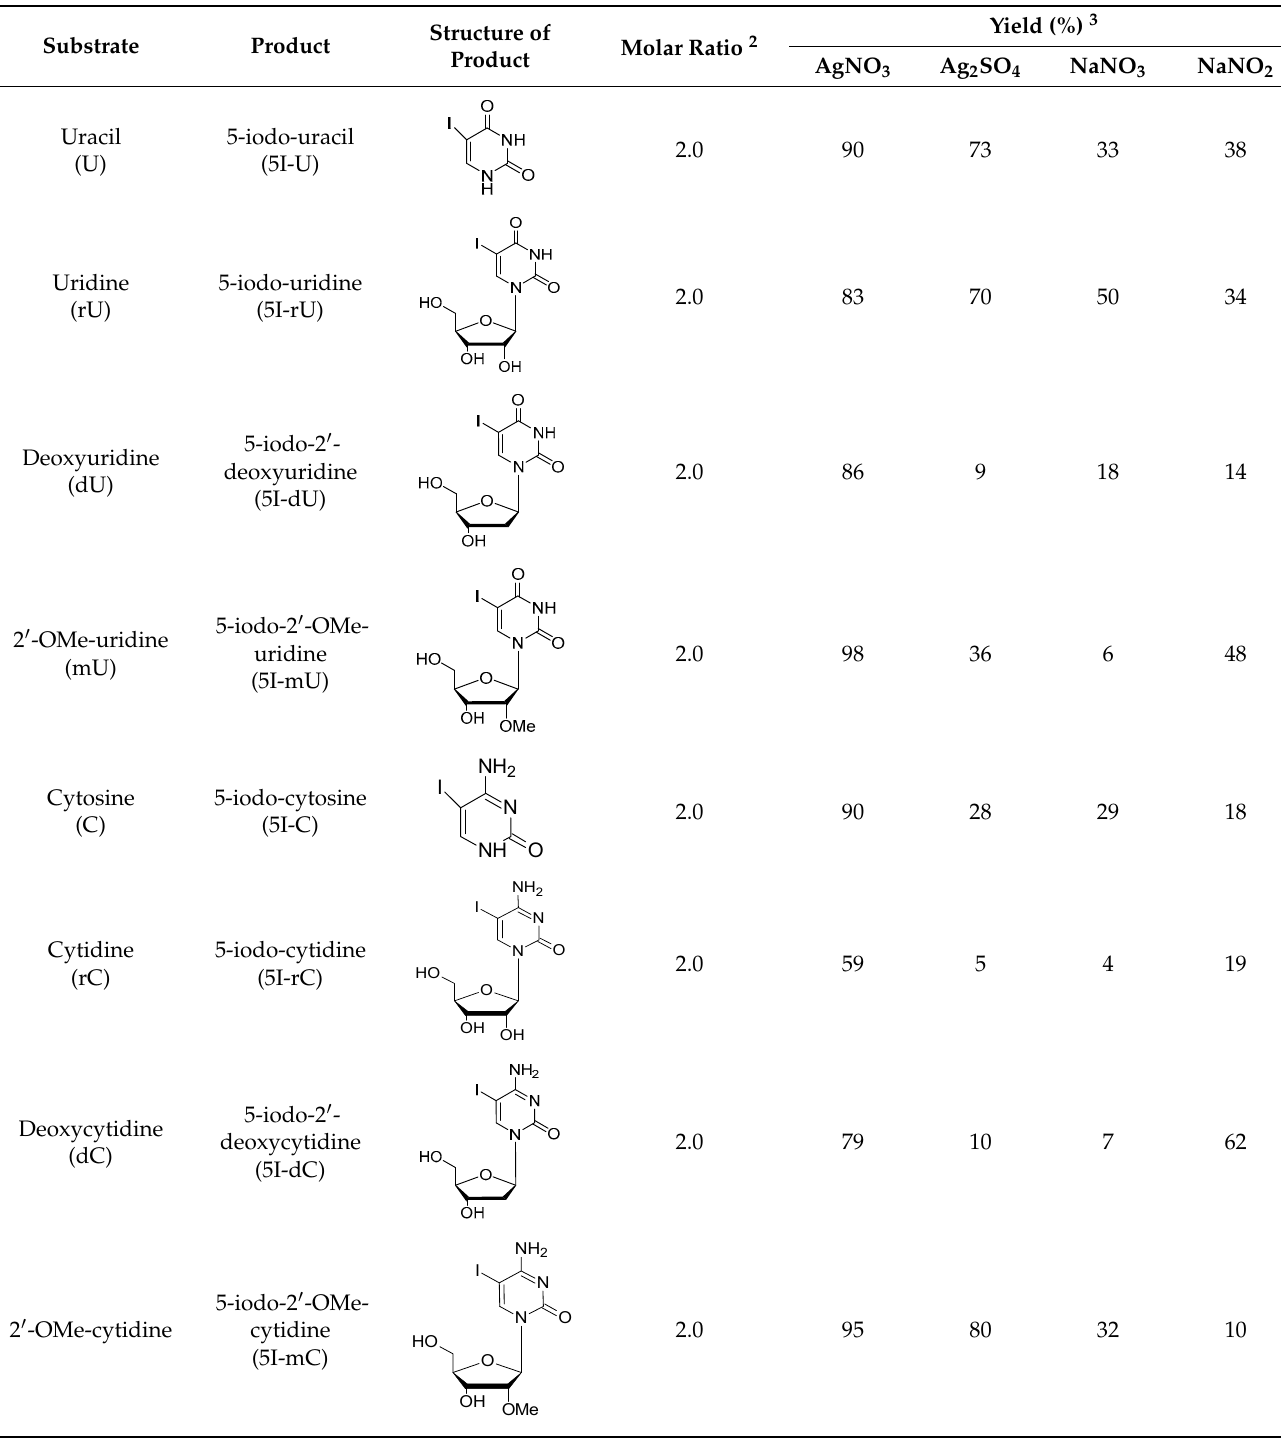
Table 3. Summary of the iodination at the C5 position of pyrimidine derivatives with metal catalysts at room temperature 1 .